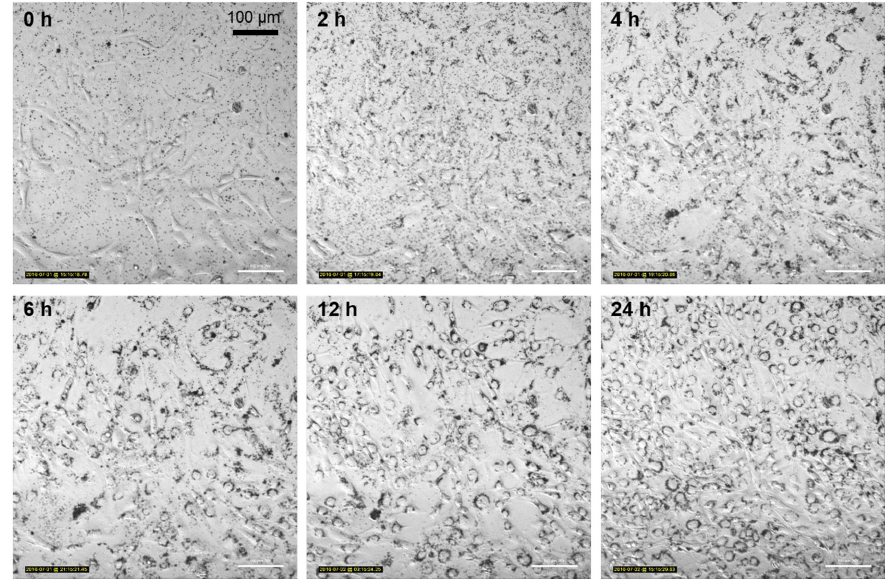
Figure 7. Time ‐ lapse microscopic imaging of NIH/3T3 cells incubated with 12.5 μ g mL − 1 FITC ‐ TiO 2 Figure 7. Time-lapse microscopic imaging of NIH/3T3 cells incubated with 12.5 µ g mL − 1 FITC-TiO 2 NPs for 24 h. Magnification 20×. NPs for 24 h. Magnification 20 ×